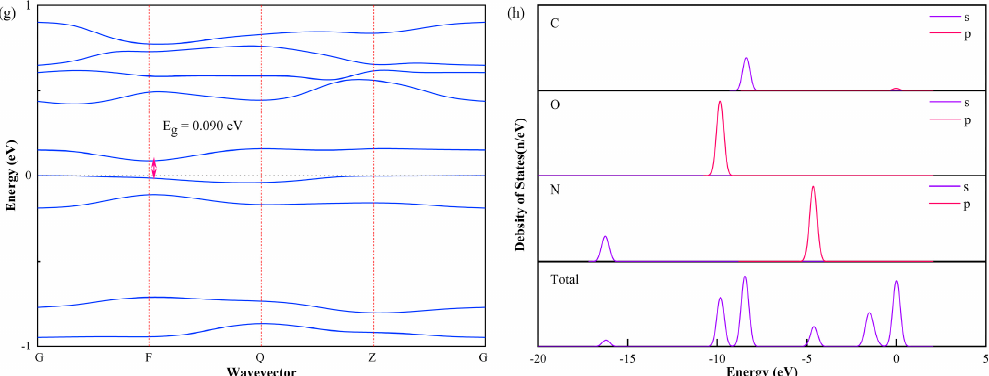
Figure 6. Band gap and Density of States of Polyamide–imide: ( a ) band structure; ( b ) PDOS and DOS; Band gap and Density of States of Polyester: ( c ) band structure; ( d ) PDOS and DOS; Band gap and Density of States of Polyesterimide: ( e ) band structure; ( f ) PDOS and DOS; Band gap and Density of States of Polyimide: ( g ) band structure; ( h ) PDOS and DOS.